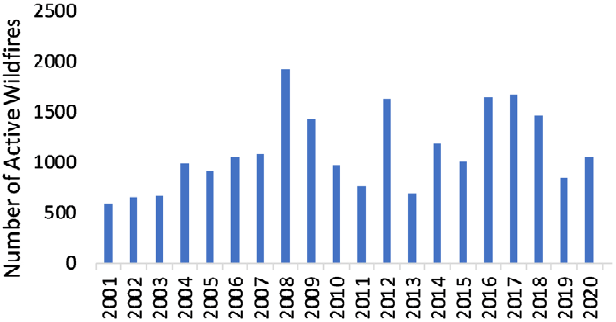
Figure 3. Total number of pixels presenting active wildfire on an annual basis (2001 to 2020).